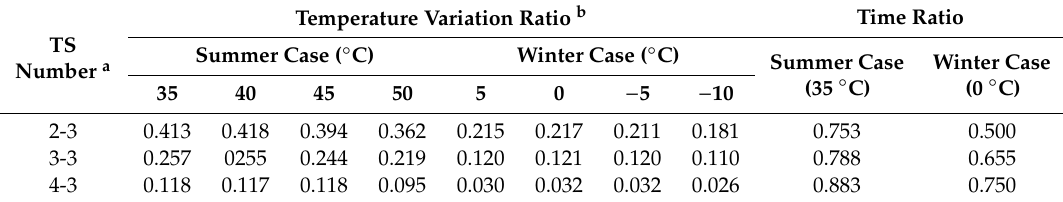
Table 5. Thermal balance parameters of No.3 TSs in Shanghai muddy clay in fluid